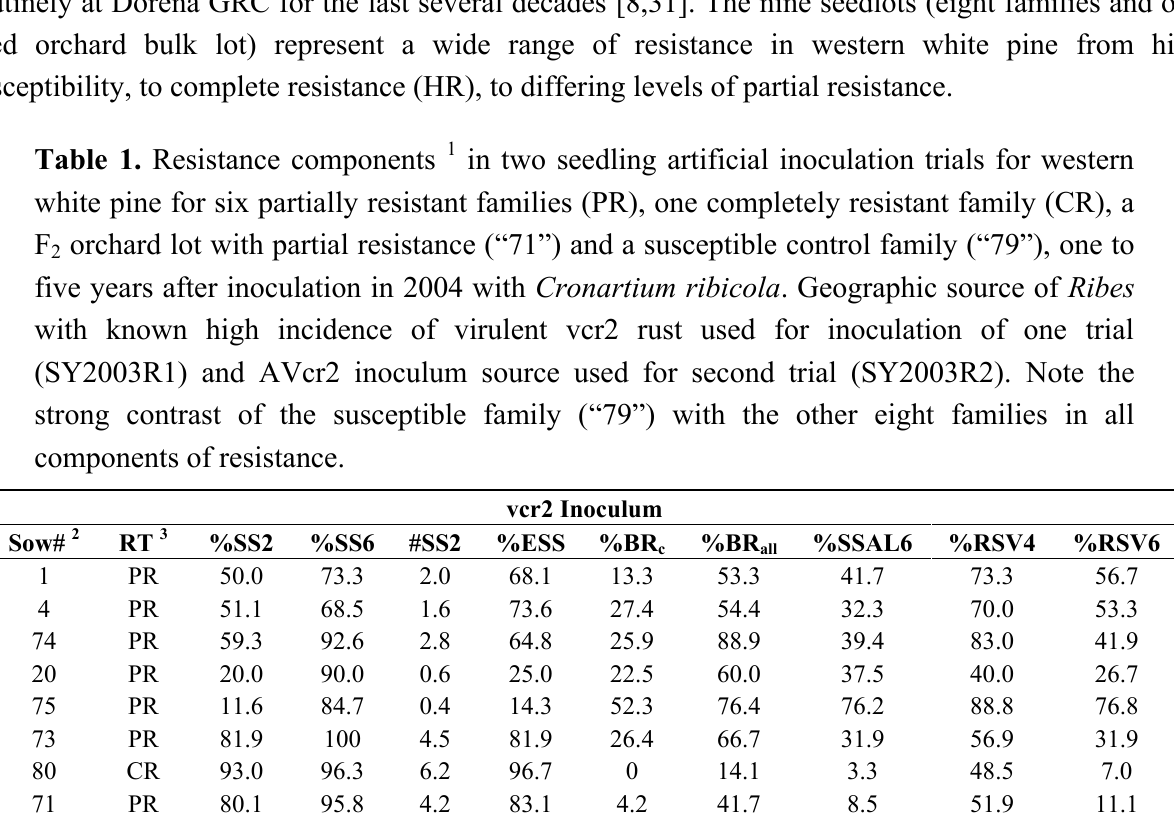
Table 1. Resistance components 1 in two seedling artificial inoculation trials for western white pine for six partially resistant families (PR), one completely resistant family (CR),